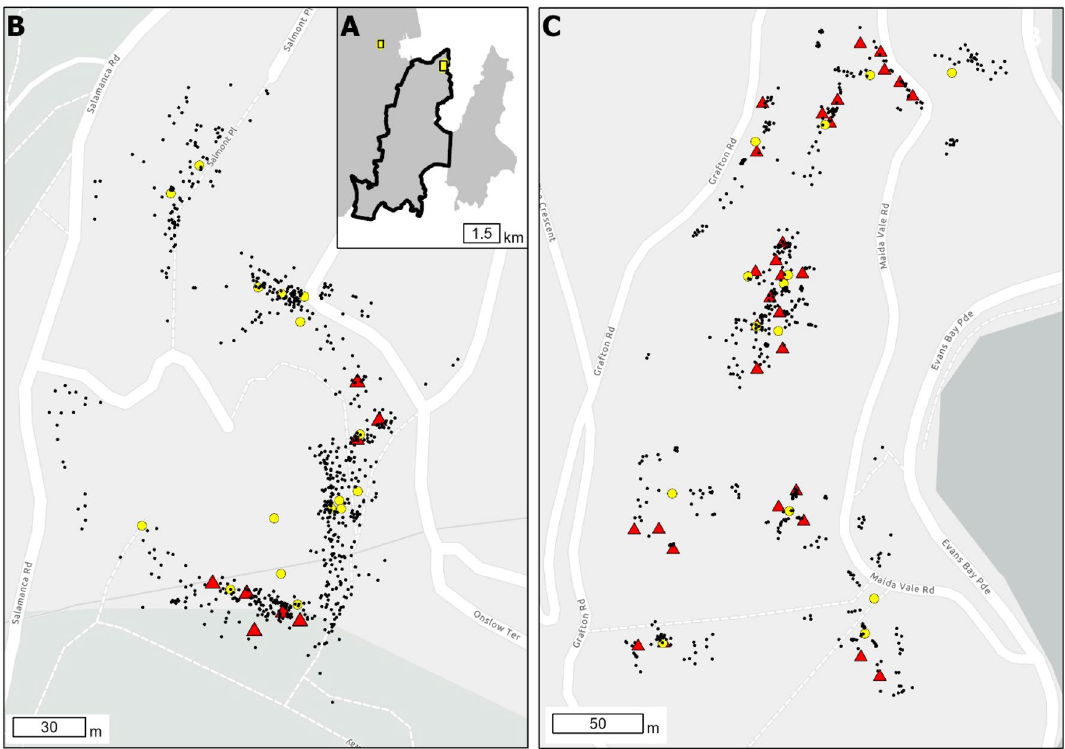
Figure 1. ( A ) The study was conducted in the suburbs of Kelburn (left yellow dot) and Roseneath (right yellow dot) in the city of Wellington, New Zealand. The black polygon represents the 1475 ha area that will be targeted for ship rat ( Rattus rattus ) eradication in Wellington city, New Zealand. In each suburb, we radio-collared ship rats and deployed three types of devices (bait stations, chew cards, and WaxTags) to estimate home range and detection parameters. ( B ) In Kelburn, we radio-collared 14 rats and deployed eight devices. ( C ) In Roseneath, we radio-collared 16 rats and deployed 30 devices. The yellow circles indicate home range centers of individual rats, the red triangles indicate the location of bait stations and detection devices, and the small black dots indicate the telemetry locations of